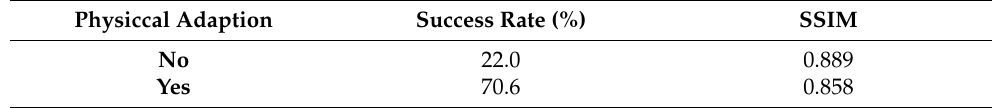
Table 4. Performance with and without patches for physical